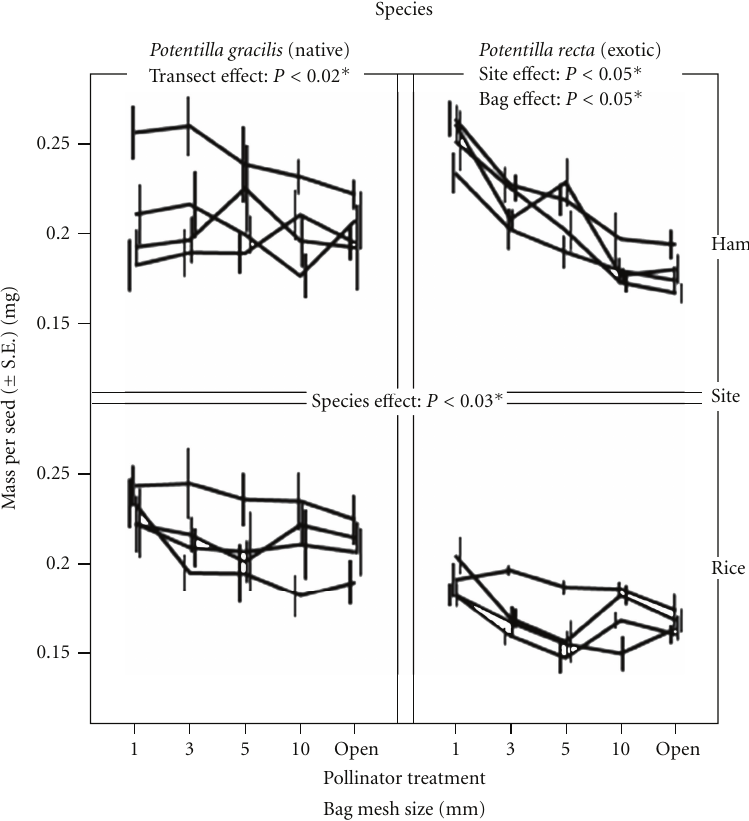
Figure 4: Mass per individual seed (mg) for Potentilla gracilis and P. recta seeds produced by flower heads exclosed by bags having mesh sizes designed to exclude various sizes of pollinators, along four transects at both Ham and Rice sites, northeastern Oregon, June-July 2003. seeds, overall di ff erences in seed number per head translated into significantly higher total seed mass per head for sulfur, compare to the native (0.31 g mass per head ± 0.02 S.E. for sulfur, versus 0.23 g ± 0.02 S.E. for the native). Once again however, native production was lower at the Rice